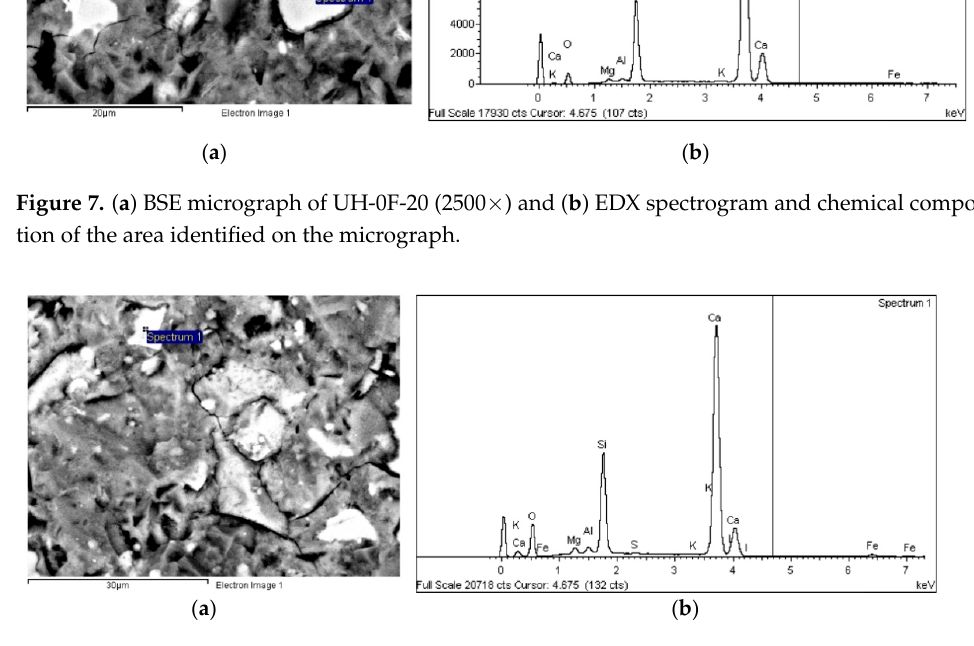
Figure 8. ( a ) BSE micrograph of UH-2F-air (2000×) and ( b ) EDX spectrogram and chemical composition of the area identified on the micrograph.